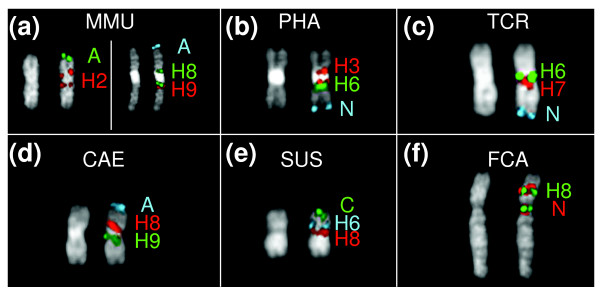
Examples of co-hybridization experiments on (a) macaque (MMU), (b) sacred baboon (PHA), (c) silvered-leaf monkey (TCR), (d) African green monkey (CAE), (e) pig (SUS), and (f) cat (FCA). The telomerically located probes in (a-e) were used for a correct identification of p and q arms of these metacentric chromosomes. The DAPI image alone is reported on the left to better show the morphology of the chromosome. Letters refer to BAC clones reported in Table 1.